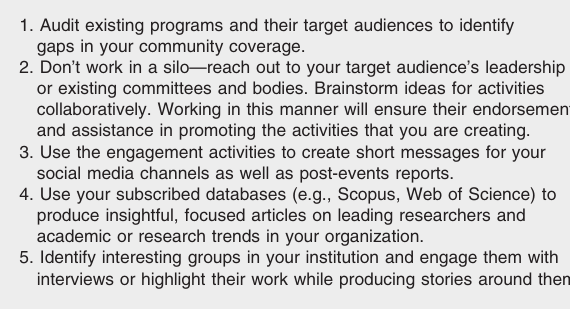
Steps to creating engagement activities and consequence